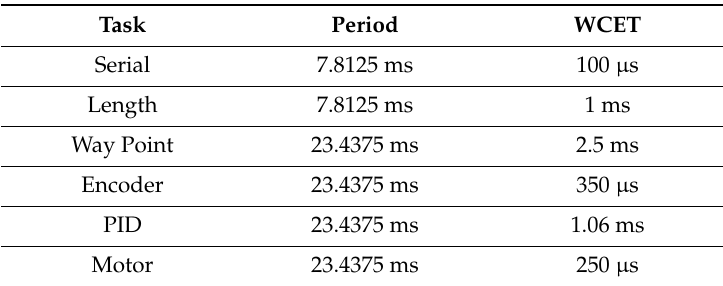
Table 2. Robotic highway safety marker (RSM) task set parameters. WCET = worst case execution time; PID = process